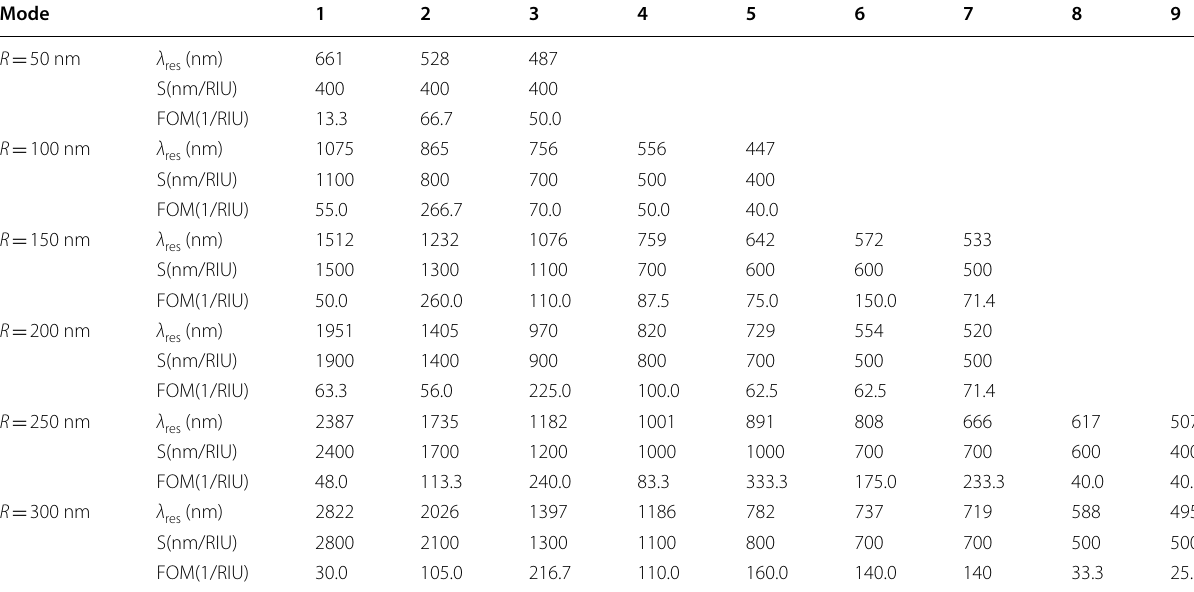
Table 3 The λ , S, and FOM corresponding to the resonance modes of the case 3 structure when R is varied from 50 to 300 nm with res an increment of 50 nm in the wavelength range of 450–3000 nm, respectively